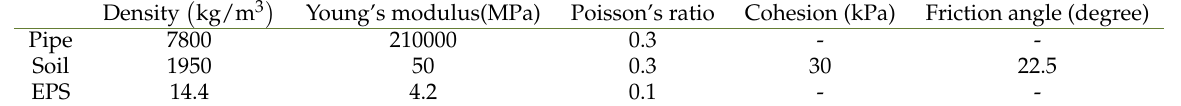
Table 1. Mechanical parameters of the model